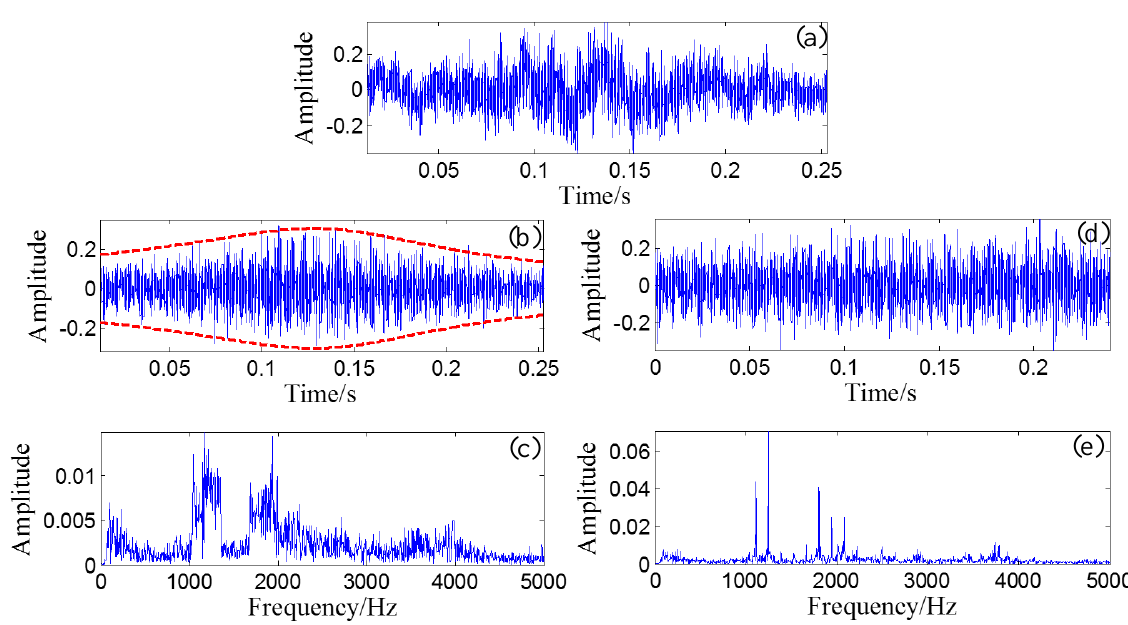
Figure 17. ( a ) Waveform of the Doppler-shifted signal with the out-race defect; ( b ) waveform of the filtered Doppler-shifted signal with the out-race defect and ( c ) its FFT spectrum; ( d ) waveform of the obtained Doppler-free signal with the out-race defect and ( e ) its FFT spectrum.